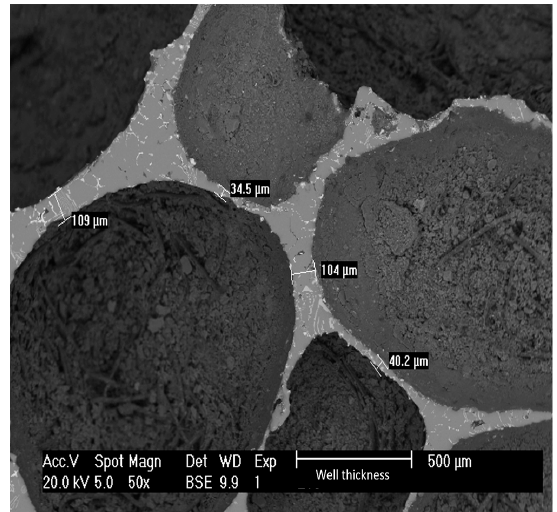
Figure 3. Scanning electron microscope (SEM) micrograph of A-242 aluminium alloy foam where the wall thickness measurements are illustrated.